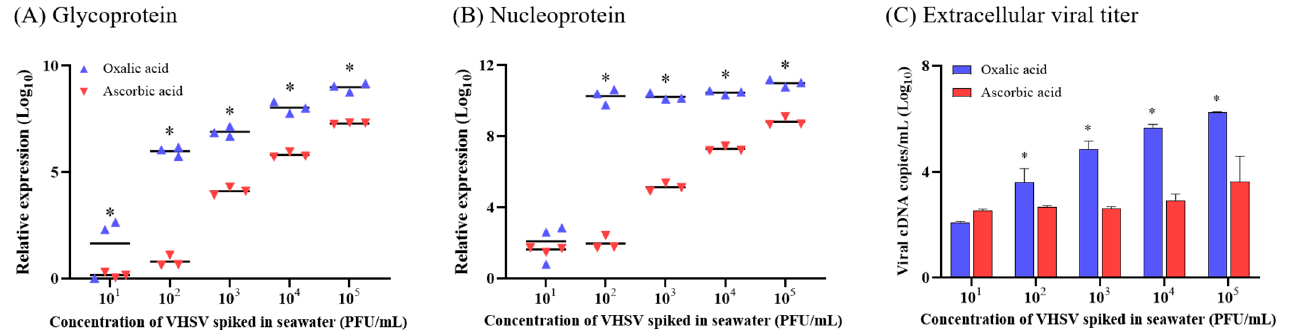
Figure 3. Comparison of the preserved infectivity of concentrates resuspended in oxalic and ascorbic acid buffers. Concentrates from VHSV spiked seawater (1 × 10 1 to 1 × 10 5 PFU/mL) were inoculated in EPC cells, and 48 h post-infection, viral gene expression levels in EPC cells and total viral cDNA copy number in the supernatant were quantified using qRT-PCR (means ± SD). A significant difference was found via two-way ANOVA (*, p < 0.05) using GraphPad Prism version 9.5.0. ( A ) G gene expression. ( B ) N